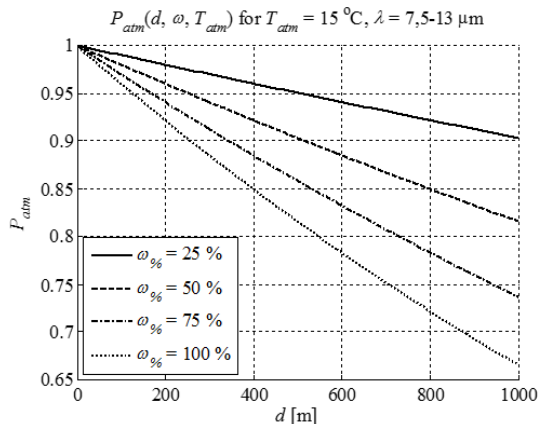
Figure 8. Characteristics of atmospheric transmission coefficient P atm = f ( d ) calculated according to the approach given in (Wi˛ecek,